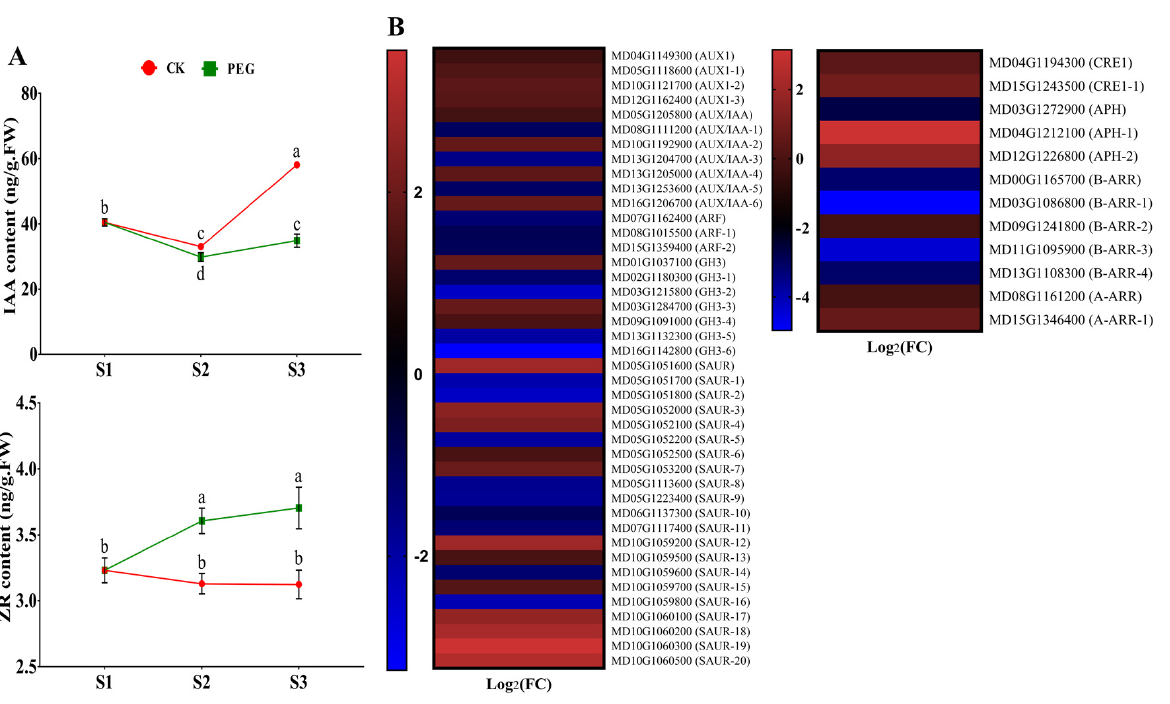
Figure 4. Effect of a polyethylene glycol (PEG) treatment on the endogenous content of indole-3-acetic acid (IAA) and zeatin riboside (ZR) over the course of this study (S1, S2, and S3) during adventitious root (AR) formation in GL-3 apple cuttings when compared to a PEG-free control (CK) group. Error bars refer to the average value ± SD from three biological replicates. Different letters indicate significant differences by least significant difference (LSD) test at p ≤ 0.05 ( A ). Selected differentially expressed genes (DEGs) related to auxin and cytokinin from RNA sequencing data (only at S2 of CK and PEG treatment). Heat map diagram of the log2FC, the red and blue colors specify up-and down-regulated expressions ( B